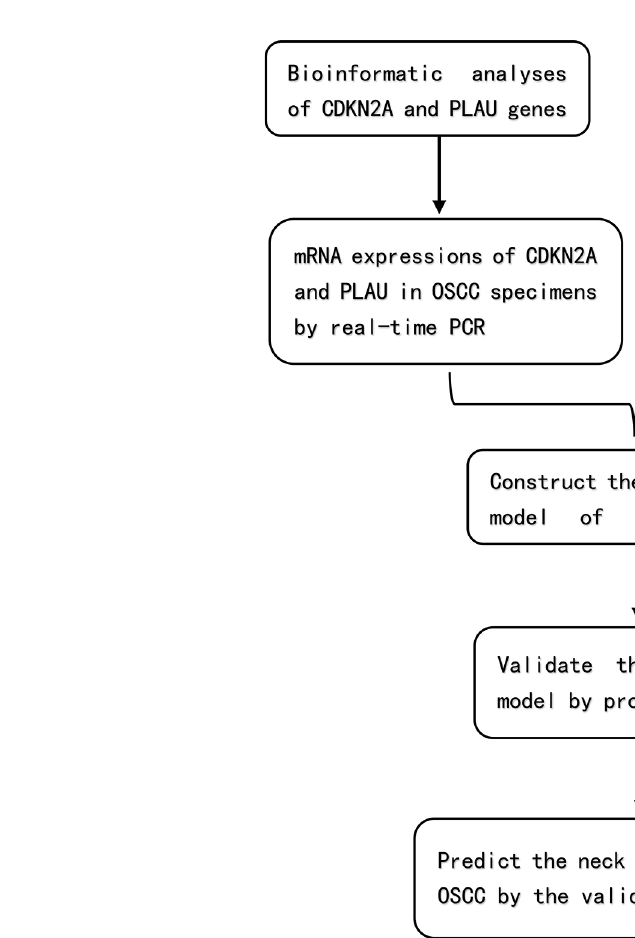
Figure 3E . The logistic regression equation is shown in Table 3 .